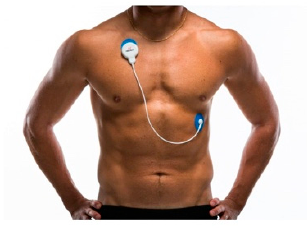
Figure 4. Firsbeat Bodyguard 2. Firstbeat Technologies Ltd.